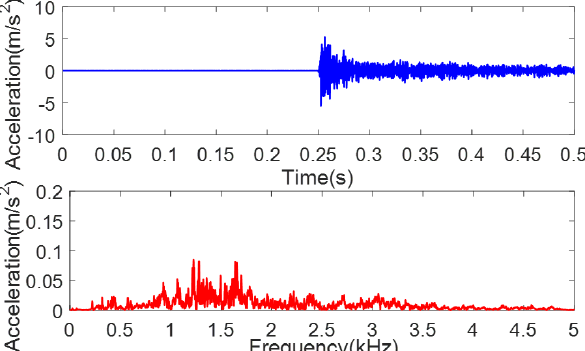
Figure 2. Inherent frequency analysis of vibration information.